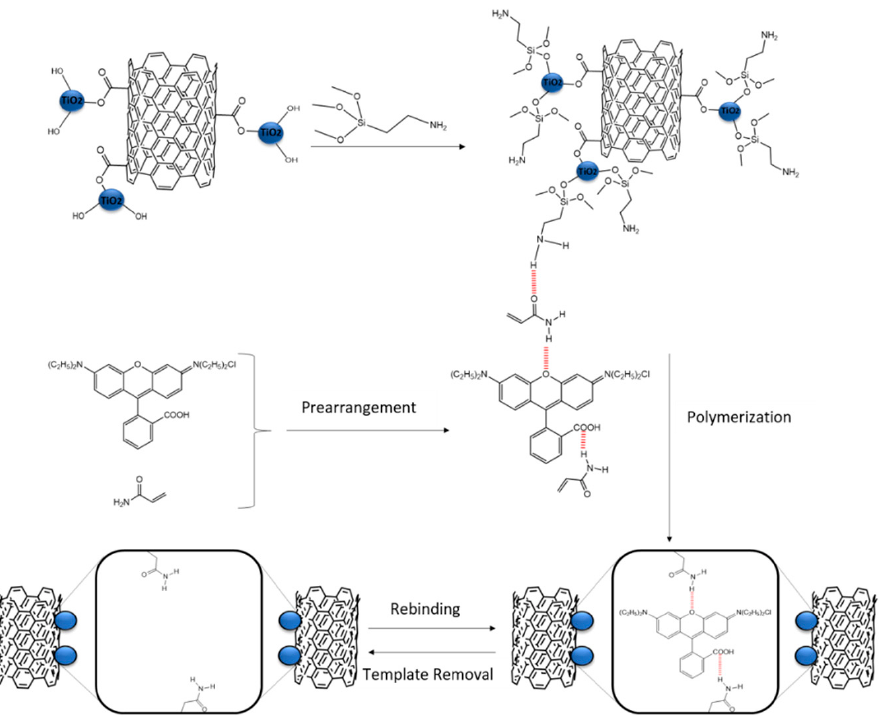
Figure 6. Schematic illustration of the construction process of MIP.